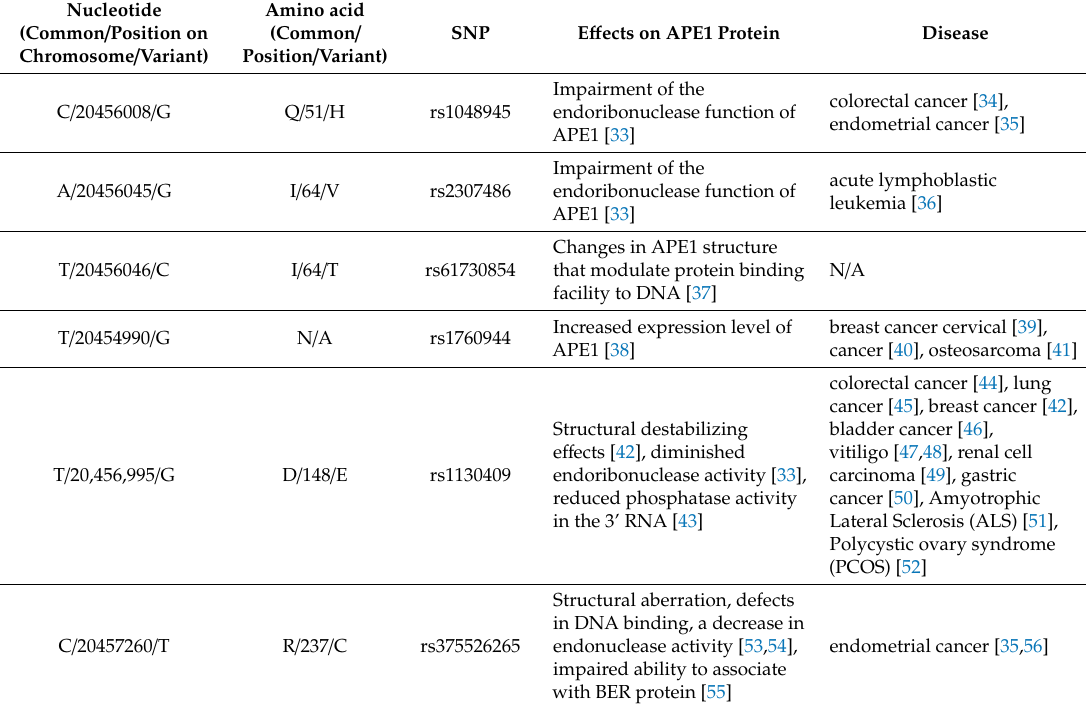
Table 1. SNPs (single nucleotide polymorphisms) in the APE1 (apurinic / apyrimidinic endonuclease 1) sequence, their e ff ects on protein structure and / or activity, and their association with